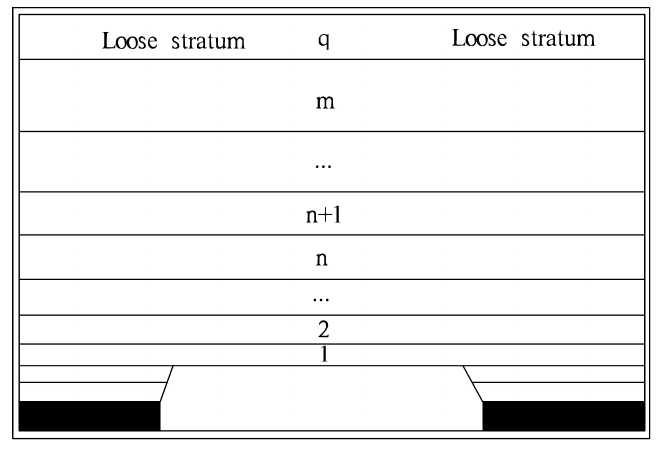
Figure 10. Calculation model of the load on the stratum [34] .